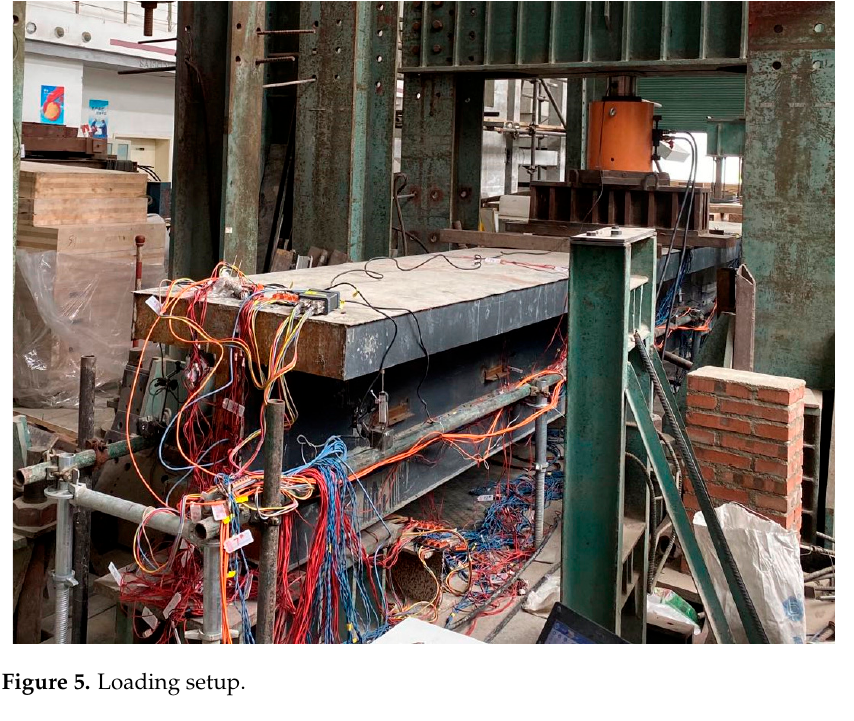
Figure 5. Loading setup.